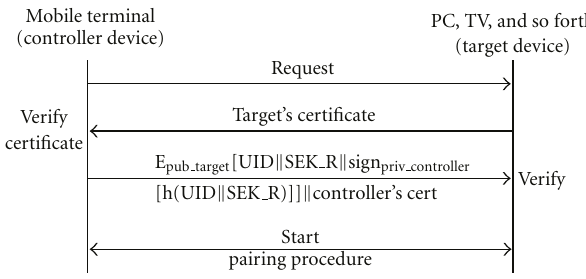
Figure 5: Mutual authentication, key